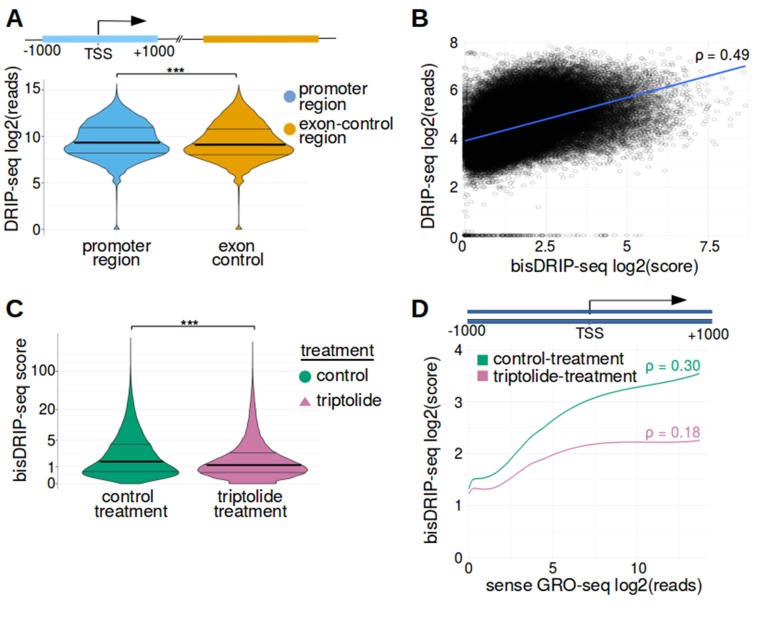
Promoter regions were enriched in high bisDRIP-seq scores.(A) DRIP-seq reads are enriched in promoter regions relative to matched exon-containing regions. R-loops were previously mapped to promoter regions (Ginno et al., 2012). To confirm that this result can be reproduced using our analysis pipeline, we compared DRIP-seq read counts in promoter regions with matched exonic regions. For each promoter region, a matched region (orange) was selected downstream of the promoter region in the same gene centered on an exonic site chosen at random. DRIP-seq read counts were calculated using DRIP-seq datasets generated by Sanz et al., 2016. DRIP-seq read counts (y-axis, log2 mean DRIP-seq reads from n = 2 samples) were plotted for promoter regions (blue, n = 60017) and matched regions (orange, n = 60017) using violin plots. Within each violin plot, the density of points at a given bisDRIP-seq score is represented by the width of the plot. Individual lines in the violin plot represent quartiles. DRIP-seq reads were significantly enriched in promoter regions relative to matched exon-centered regions. ‘TSS’ refers to the transcription start site. ***p<2.2×10−16, Wilcoxon signed-rank test. (B) bisDRIP-seq scores and DRIP-seq scores are correlated in promoter-regions. Since DRIP-seq is the conventional mapping technique to map R-loops at low resolution, we compared DRIP-seq and bisDRIP-seq results at the resolution provided by DRIP-seq. For each promoter region (n = 78218), the DRIP-seq read count (y-axis, log2 mean DRIP-seq reads from n = 2 samples) of the promoter region was plotted against the bisDRIP-seq score (x-axis, log2 mean bisDRIP-seq score from n = 13 samples) of the promoter region. A line of best fit (blue) was then plotted using the ggplot2 ‘lm’ function. The two datasets were significantly correlated (p<2.2×10−16, Spearman's test using asymptotic t approximation) with a Spearman's ρ of 0.49 and a Pearson correlation coefficient of 0.45. Thus, bisDRIP-seq and DRIP-seq provide reasonably similar results at 2 kb resolution despite the major differences between the two mapping approaches. (C) bisDRIP-seq scores are reduced in promoter-regions after transcription inhibition. R-loops were previously shown to be transcription dependent (Sanz et al., 2016). To confirm that the high bisDRIP-seq scores in promoter regions were also transcription-dependent, we repeated bisDRIP-seq in the presence of the transcription-inhibitor triptolide. The distribution of promoter region bisDRIP-seq scores (n = 78218) were plotted for control-treated samples (green, log2 mean bisDRIP-seq score from n = 13 samples) and triptolide-treated samples (purple, log2 mean bisDRIP-seq score from n = 2 samples). The width of the overlapping violin plot represents the fraction of promoter regions that had a given bisDRIP-seq score. Individual lines in the violin plot represent quartiles. The bisDRIP-seq scores in promoter regions were higher in control-treated samples than triptolide-treated samples. This suggests that the enrichment of high bisDRIP-seq scores in promoter regions was at least partially transcription-dependent. ***p<2.2×10−16, Wilcoxon signed-rank test. (D) bisDRIP-seq scores are correlated with promoter activity. R-loops were previously shown to correlate with the level of gene expression (Sanz et al., 2016). We therefore asked if bisDRIP-seq scores are higher in promoter regions with high promoter activity. Promoter activity and bisDRIP-seq scores were assessed in the region between the transcription start site and + 1000 bp in all promoter regions (n = 78218). A LOESS smoothed curve was plotted of bisDRIP-seq scores (y-axis) at different levels of promoter activity (x-axis). This was repeated for control-treated samples (green, log2 mean bisDRIP-seq score from n = 13 samples) and samples treated with the transcription-inhibitor triptolide (pink, mean log2 bisDRIP-seq score from n = 2 samples). bisDRIP-seq scores tend to be higher in promoter regions with higher promoter activity. This difference between promoter regions with high and low activity was reduced in samples treated with triptolide. These results suggest that the bisDRIP-seq score of promoter-regions correlates with promoter activity. Promoter activity was calculated as the mean number of sense-strand GRO-seq reads measured in the region between the transcription start site and + 1000 bp by Hah et al., 2013. Both promoter activity and bisDRIP-seq scores were plotted on log2-transformed axes. p refers to the Spearman's correlation coefficient for each plot.